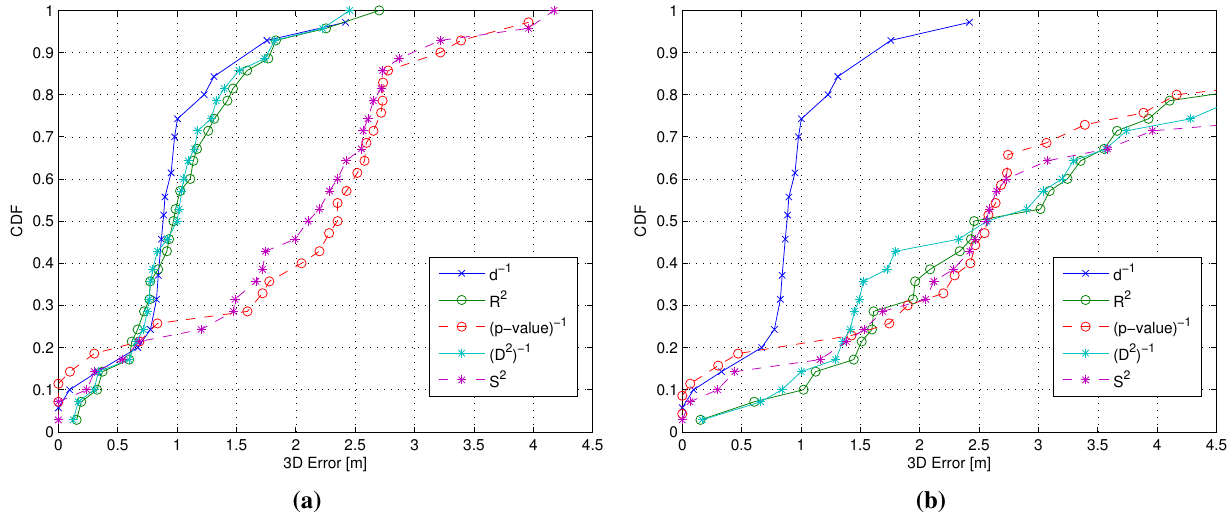
Figure 4. CDF of the 3D positioning error (cid:15) with k = 3 . ISIW, ideal sorting/ideal weighting; ISRW, ideal sorting/real weighting; RSRW, real sorting/real weighting. ( a ) ISIW ( d − 1 ) vs. ISRW ( R 2 , ( p -value ) − 1 , ( D 2 ) − 1 and S 2 ); ( b ) ISIW ( d − 1 ) vs. RSRW ( R 2 , ( p -value ) − 1 , ( D 2 ) − 1 and S 2 ).